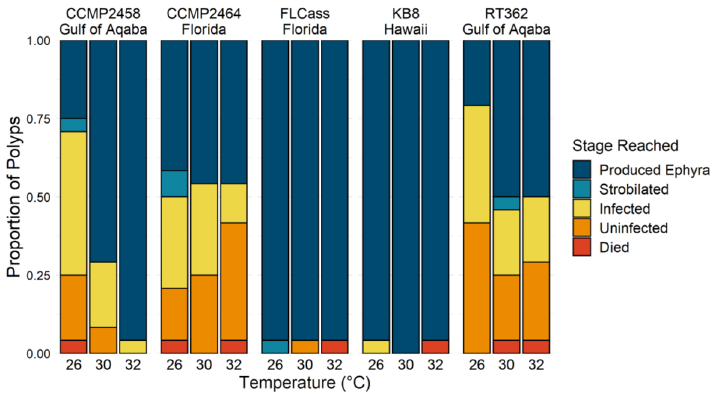
Figure 7. Proportion of polyps in each stage of development that died before infection, were uninfected or infected, strobilated, or released an ephyra at the end of the experiment.